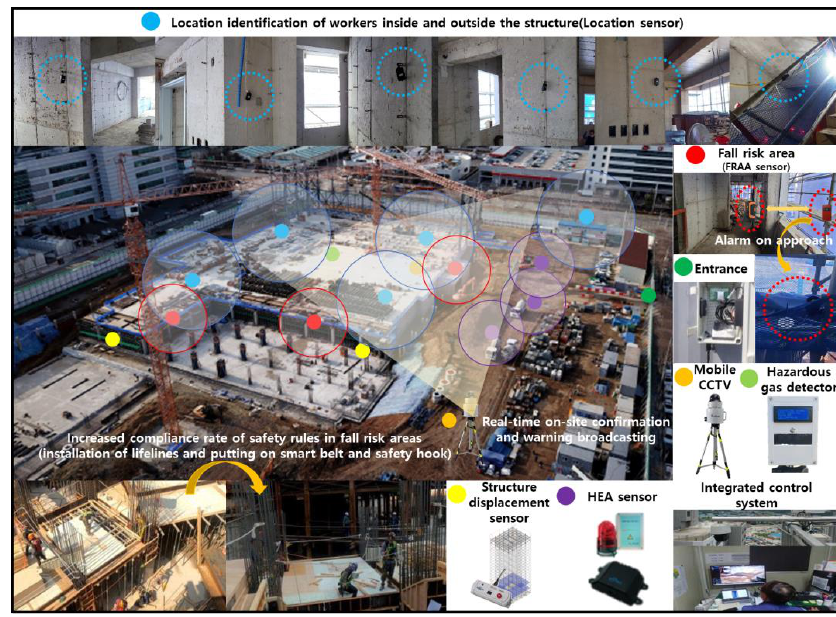
Figure 17. SCST installation and operation plan in small- and medium-sized